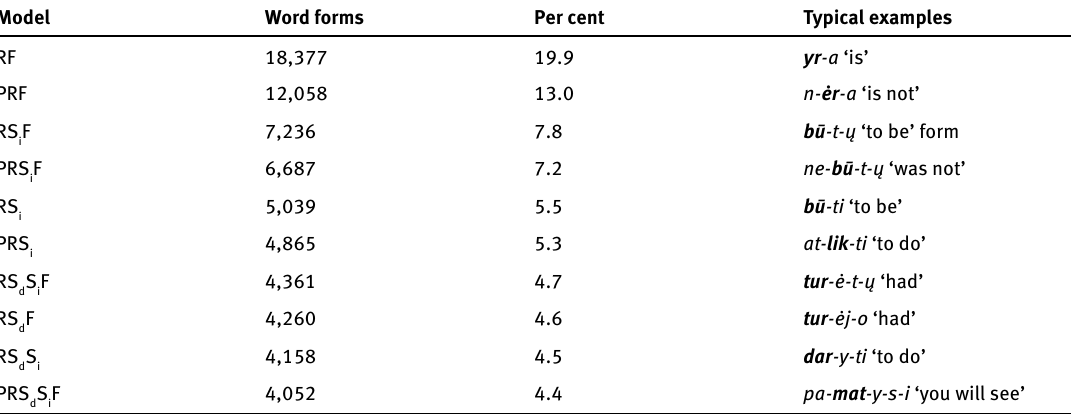
Table 2. The Most Productive Verb Models